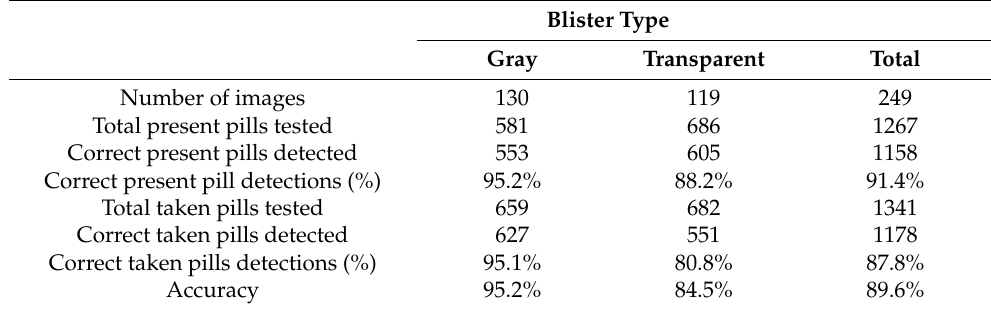
Table 3. Results of Test 3 (Counting